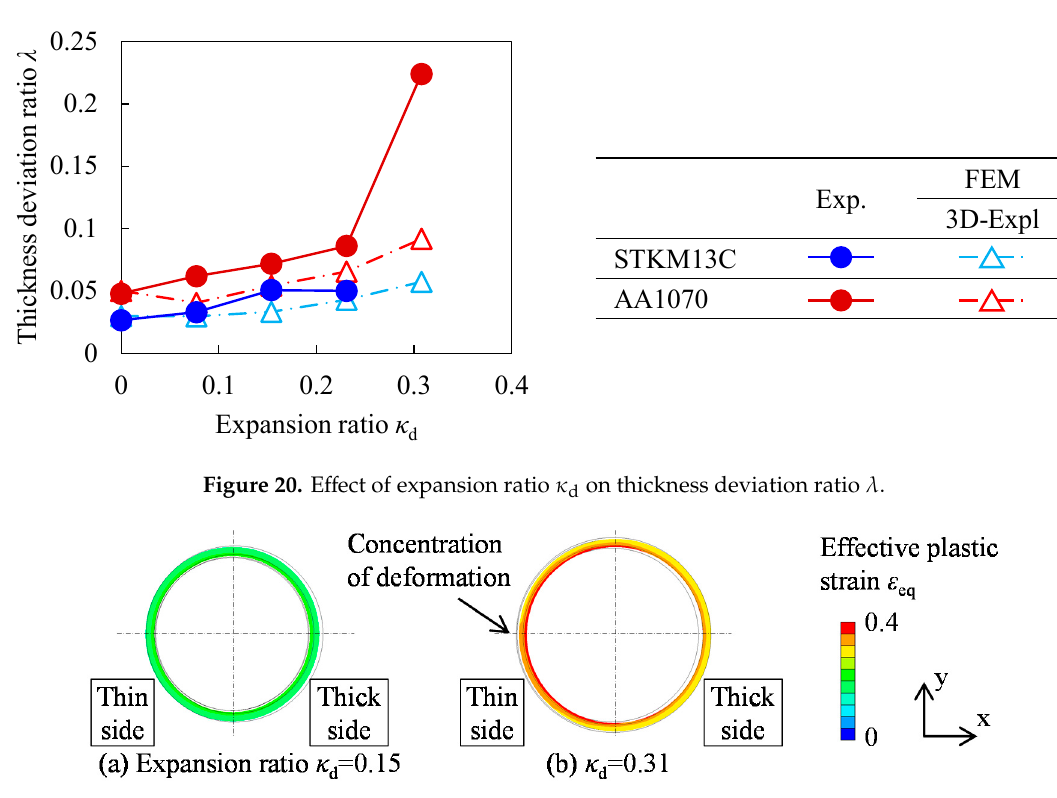
Figure 21. Distribution of effective plastic strain ε eq at cross section of tube (AA1070).